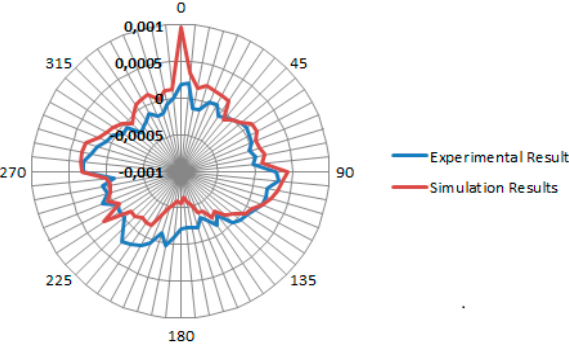
Figure 6. Comparison between results of experimental probe head errors identification and simulation using developed model for A = 75 and B = 80.